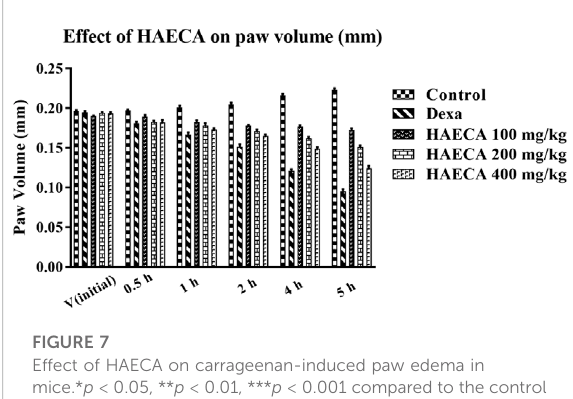
FIGURE 7 Effect of HAECA on carrageenan-induced paw edema in mice.* p < 0.05, ** p < 0.01, *** p < 0.001 compared to the control group. ANOVA (one-way) followed by post hoc analysis (Tukey ’ s multiple comparison test).